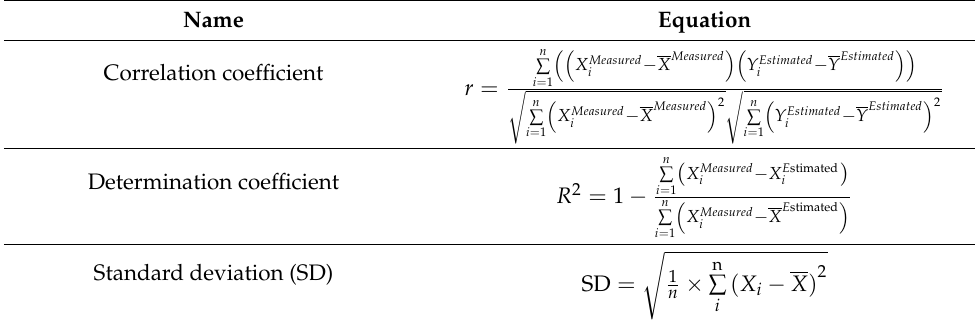
Figure 2. Analytical framework applied in the present study. Table 4. WQPs statistical